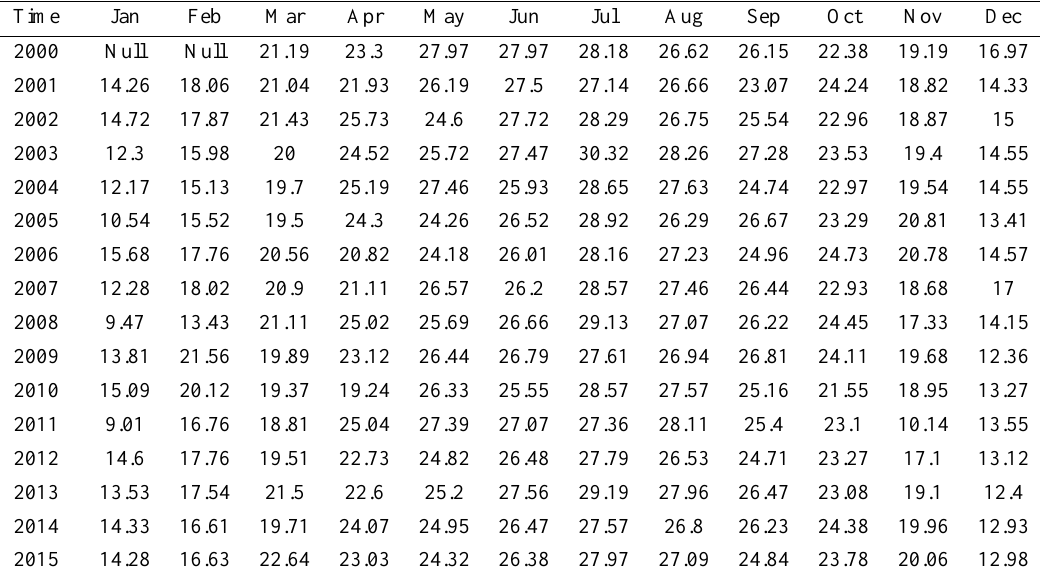
Table 3. The monthly average LST of Fujian Province from 2000 to